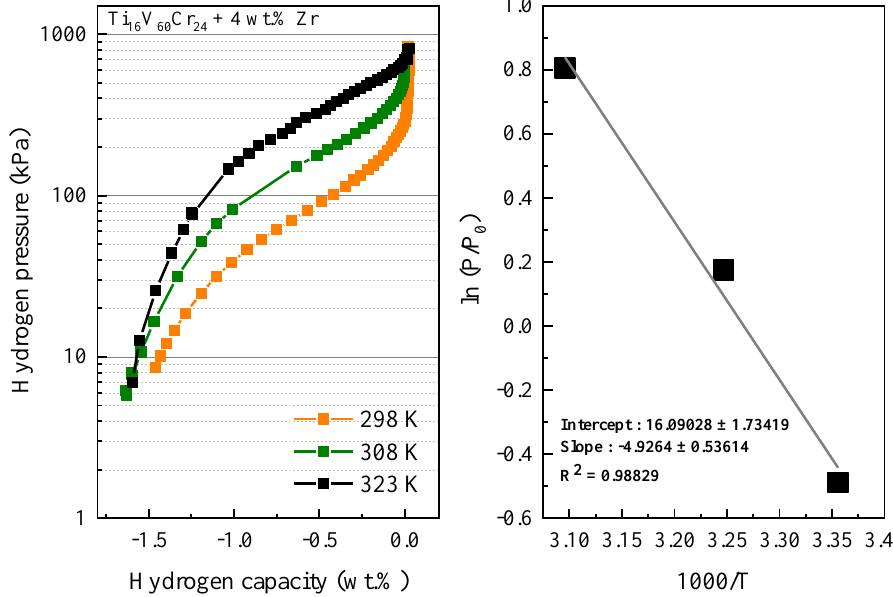
Figure 7. Desorption PCI curves of Ti 16 V 60 Cr 24 + 4 wt.%Zr at 298, 308 and 323 Figure 7 . Desorption PCI curves of Ti 16 V 60 Cr 24 + 4 wt.%Zr at 298, 308 and 323 K.